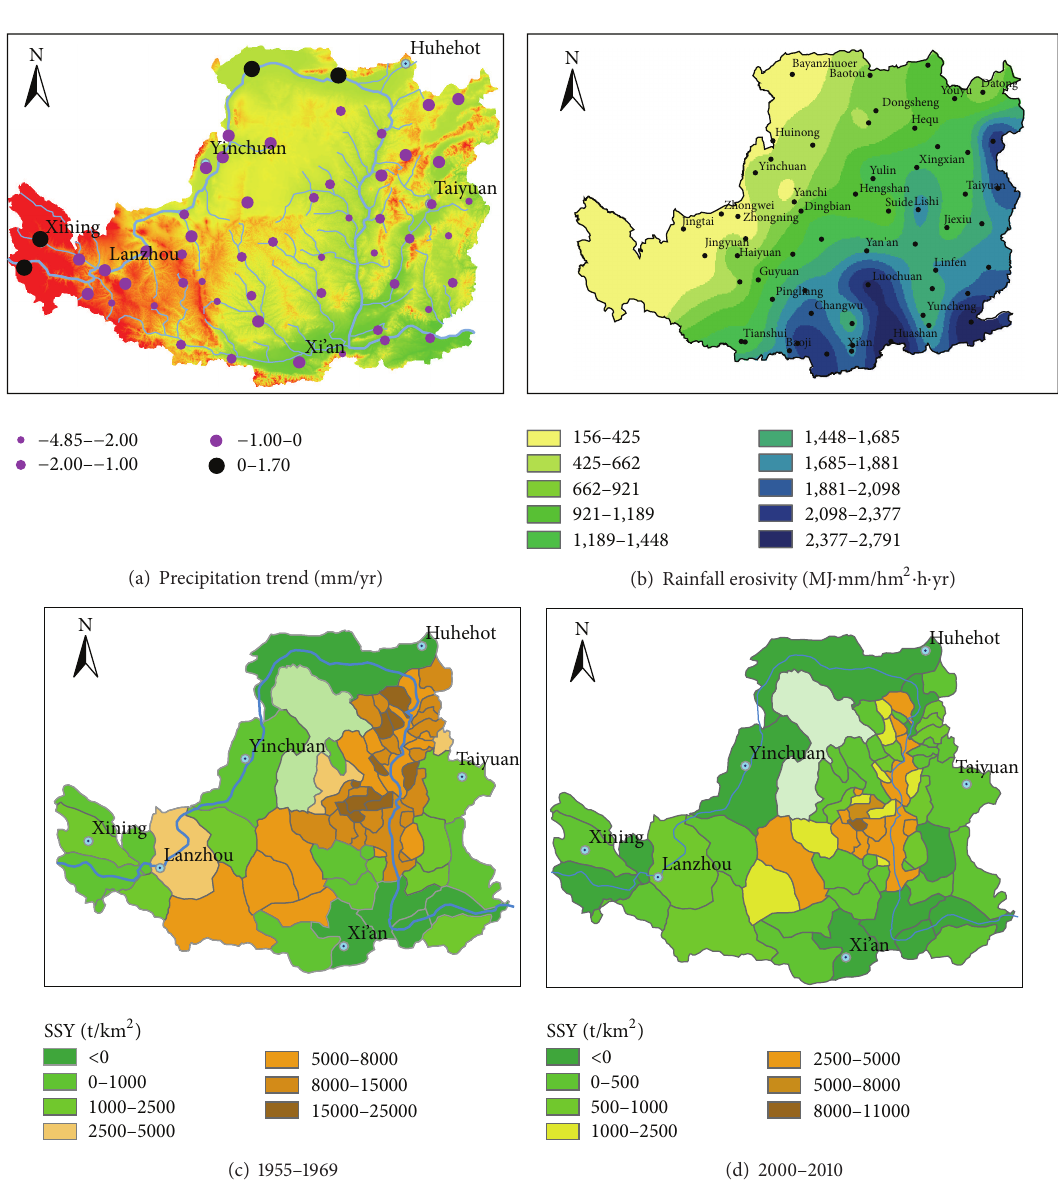
Figure 2: Distribution of precipitation, rainfall erosivity, and specific soil yield (SSY) in Loess Plateau (modified after [37]). ((a) Precipitation trend distribution map, (b) rainfall erosivity distribution map, (c) specific soil yield distribution map (1955–1969), and (d) specific soil yield distribution map